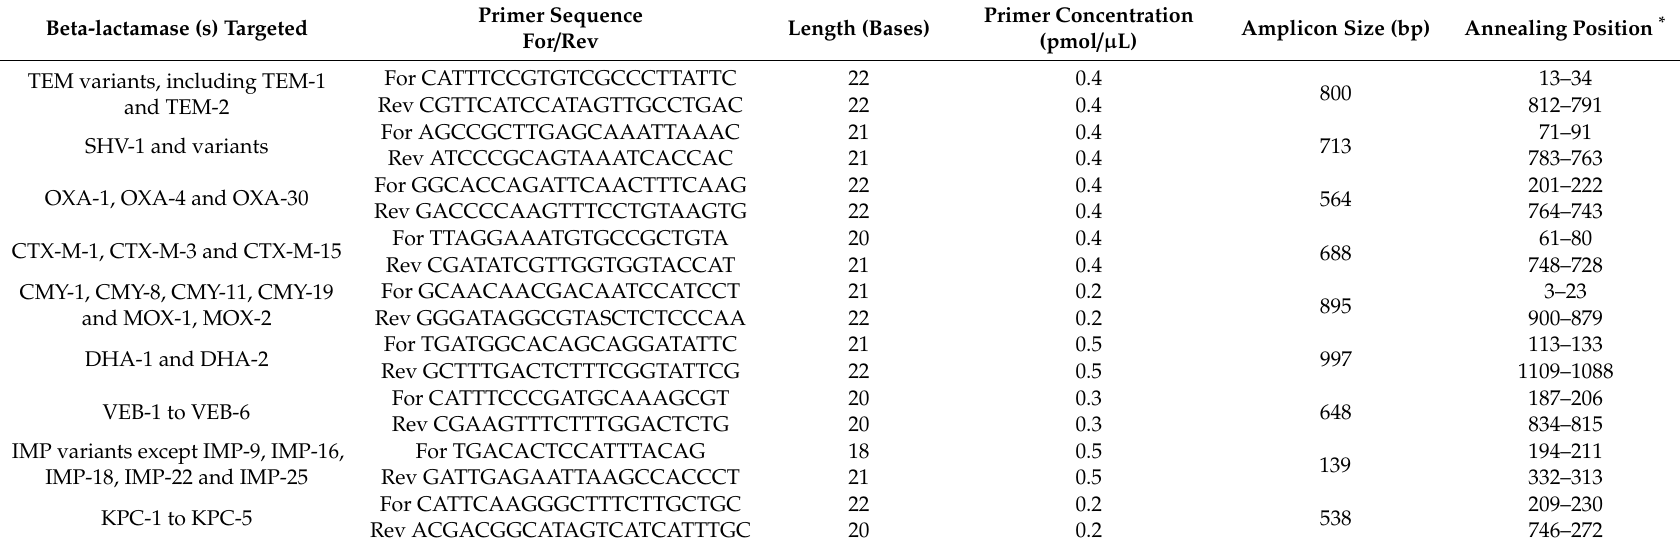
Table 1. Group-specific primers used for polymerase chain reaction (PCR) multiplex assay